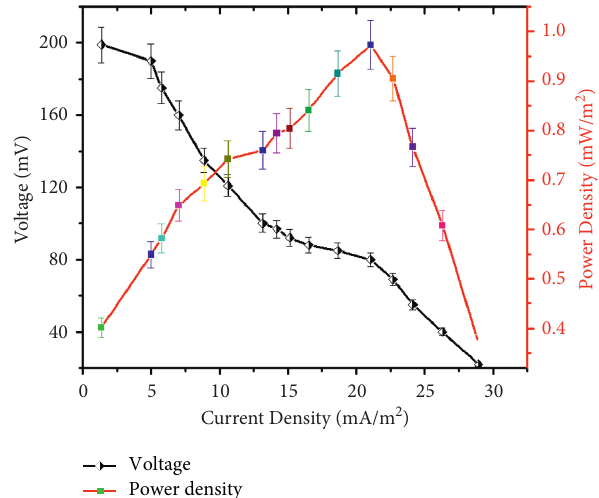
Figure 2: Polarization behavior of the MFC operation fed with mango